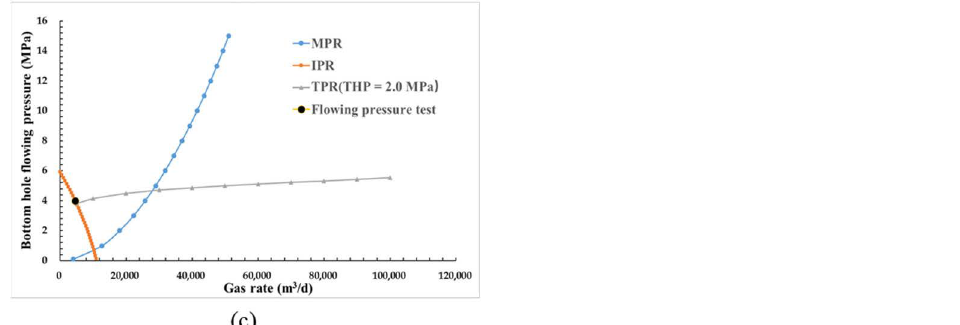
Figure 14. Gas well with: ( a ) no liquid loading, ( b ) with liquid loading but measures can be taken to improve production, and ( c ) with liquid loading but nothing can be carried out to improve